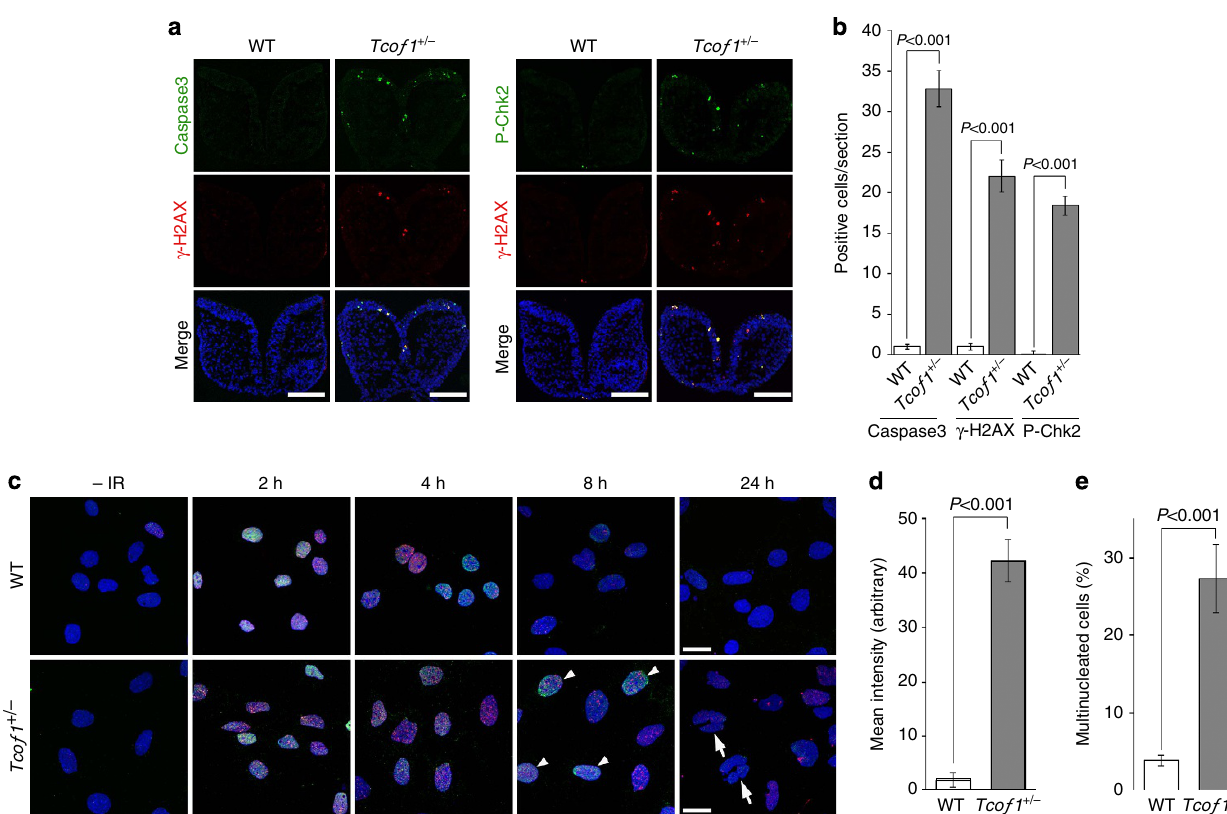
Figure 3 | Tco f 1 deficiency causes dysfunction of DNA damage repair and subsequent apoptosis. ( a ) g -H2AX-, phosphorylated Chk2 at T68 (P-Chk2)- and cleaved Caspase 3 (Caspase 3)-positive cells were detected by immunofluorescence at fore–mid brain level of E8.5 embryos (somite number 6–8). Scale bar, 100 m m. ( b ) The number of Caspase 3- and g -H2AX-positive cells within the neuroepithelium was counted in 20 histological sections obtained from five embryos. Data are mean ± s.e. Statistical differences were assessed with Student’s t -test, and P values are shown. ( c ) Accumulation of P-ATM (red) and g -H2AX (green) in MEF cells derived from wild-type (WT) and Tco f 1 þ / (cid:2) embryos were analysed by immunostaining after indicating time of X-ray irradiation or without irradiation (IR (cid:2) ). Arrowheads indicate cells having DNA damage-induced foci due to the delay in the DNA damage repair. Arrows indicate cells showing the multinucleation caused by severe DNA damage repair deficiency. Scale bars, 10 m m. ( d ) g -H2AX and P-ATM intensity examined in culture 8h after of irradiation was quantified with the ImageJ. Data are mean ± s.e. of 10 independent cells. Statistical differences were assessed with Student’s t -test, and P value is shown. ( e ) Percentages of cells showing multinucleation in culture 24h after of irradiation are presented. Data are mean ± s.e. of 50 independent cells. Statistical differences were assessed with Student’s t -test, and P value is (H 2 -DCFDA), we detected high levels of ROS in E8.5 wild-type embryos (Fig. 5a,b). Transverse sections of the cranial region clearly demonstrated that neuroepithelial cells exist endogenously in a highly oxidative state relative to cells in the non-neural ectoderm, mesoderm and endoderm (Fig. 5a).